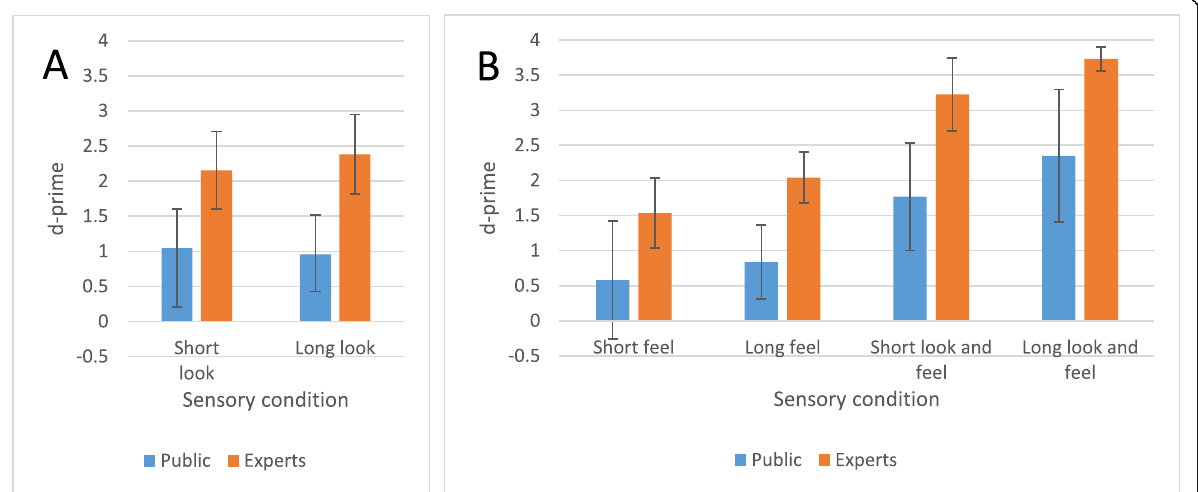
Fig. 7 Comparing mean sensitivity scores and their error bars (standard deviation (SD)) as a function of exposure time, perceptual modality and expertise across both experiments. a Results for Experiment 1 (solely gauging vision). b Results for Experiment 2 (gauging touch and the combination of touch and vision)